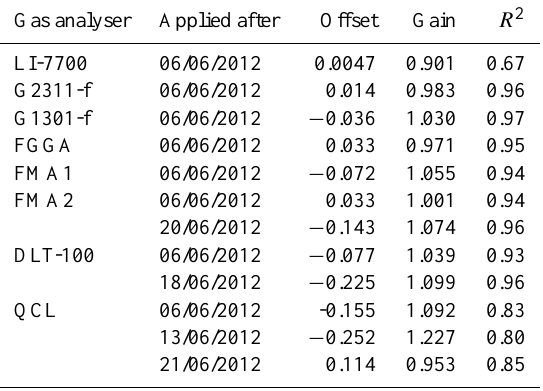
Table 2. Calibration coefficients for different instruments used in this study. Values for offset are given in ppm for gas analysers other than LI-7700. For LI-7700 the coefficient is given in mmolm − 3 . Values for the coefficient of determination are given in the last col- umn. LI-7700 data are affected by an external data-logging problem (Sect.